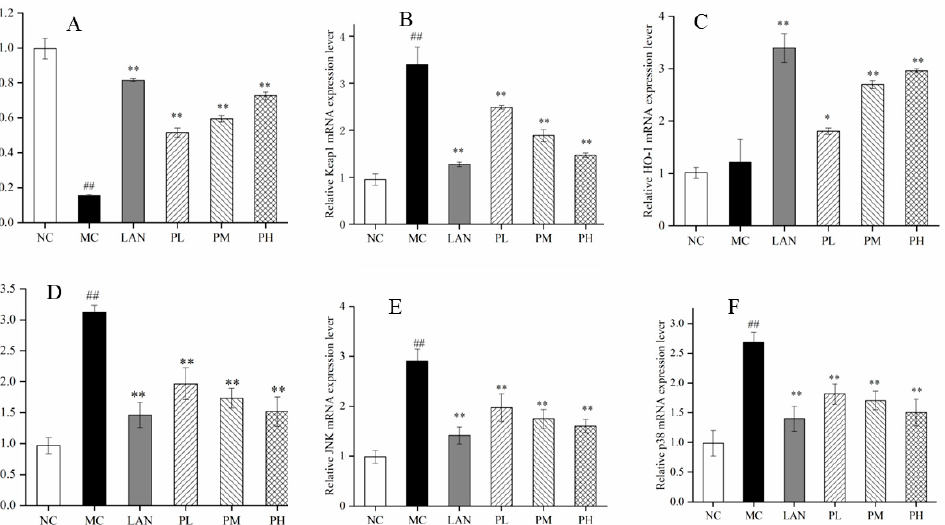
Figure 5. Effects of piperine on the mRNA expression of Nrf2 ( A ), Keap1 ( B ), HO-1 ( C ), ERK ( D ), JNK ( E ) and p38 ( F ) in the full-thickness gastric tissue of the rats. Ave ± SD, ## p < 0.01 vs. NC group; * p < 0.05 and ** p < 0.01 vs. MC group.